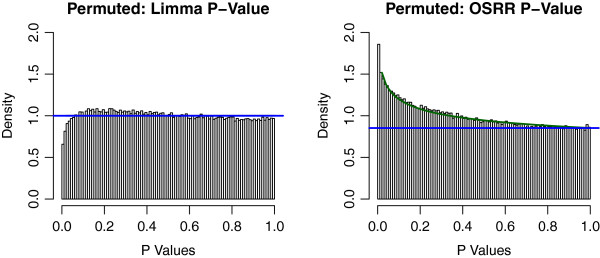
Histogram of the p-values of the from the permuted chromosome deletion study. The conventional analysis method has a slightly conservative, non-uniform null distribution. Whereas, the OSRR method has slightly anti-conservative, non-uniform null distribution.